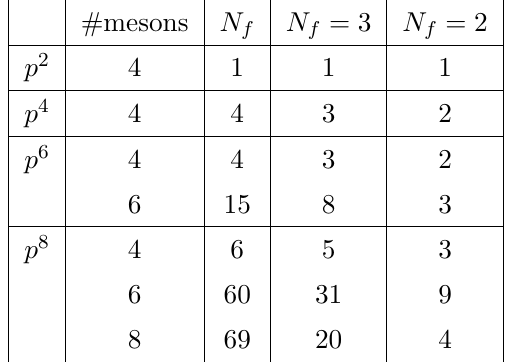
Table 7 . Number of monomials in the minimal basis for the case with no external (cid:12)elds included that produce vertices starting at the given number of